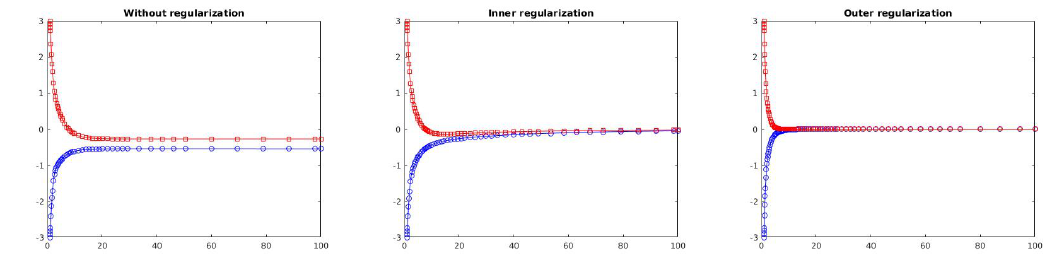
Fig. 4: Trajectories of (FB) , (FBIR) and (FBOR) for λ = 1 and γ = 0.15